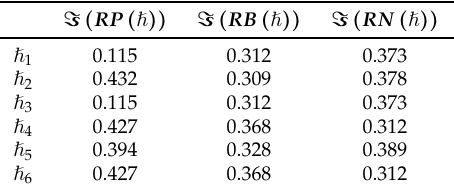
Table 9. The closeness index in this